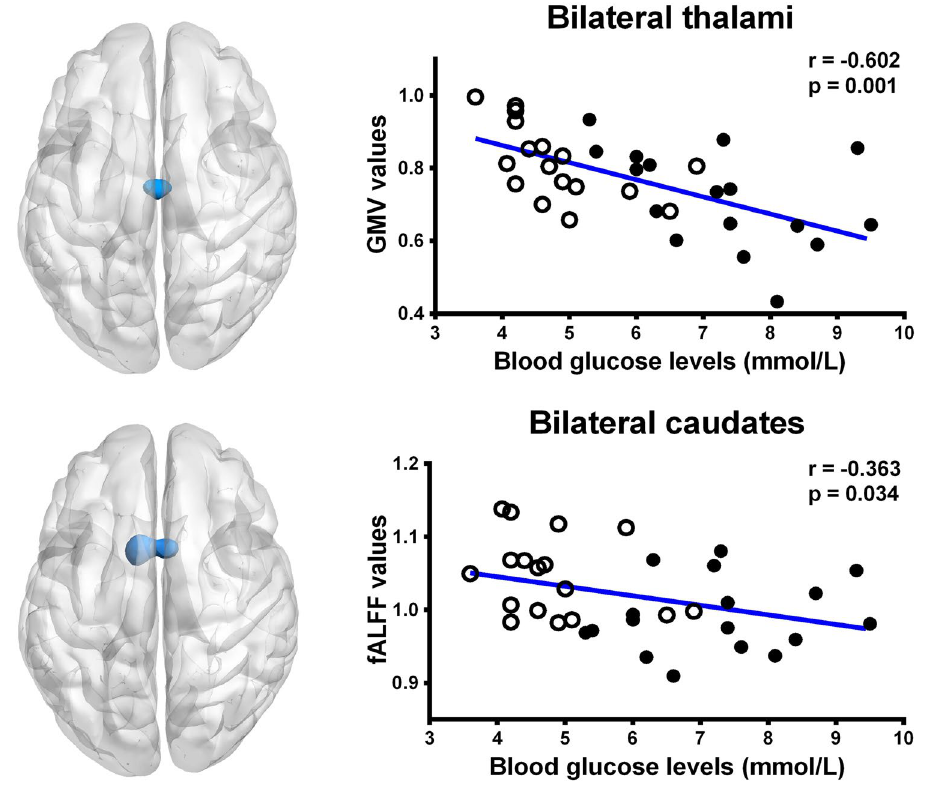
Figure 3. Correlation results in all cirrhosis patients. There was a negative correlation between the blood glucose levels and gray matter volume in bilateral thalami (r = − 0.602, P = 0.001) and the fALFF values (r = − 0.363, P = 0.034) in the bilateral caudates in all cirrhosis patients. GMV = gray matter volume; fALFF = fractional amplitude of low-frequency fluctuation; ⚪ = diabetic cirrhosis patient; ● = non-diabetic cirrhosis